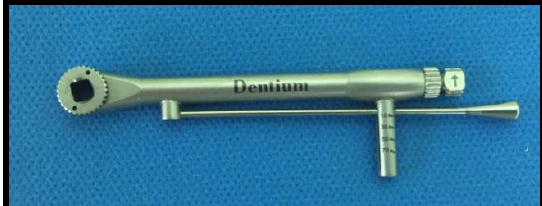
Figure 1: Implant insertion using manual calibrated torque ratchet